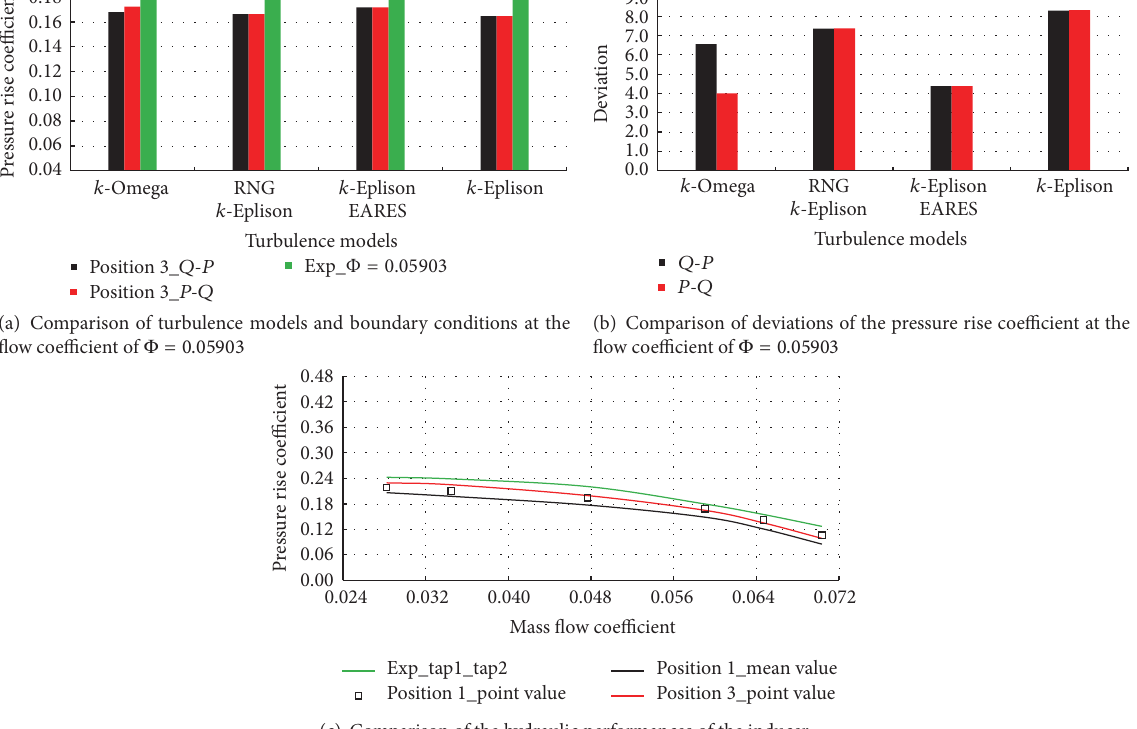
Figure 7: Comparison of different boundary conditions and different turbulence